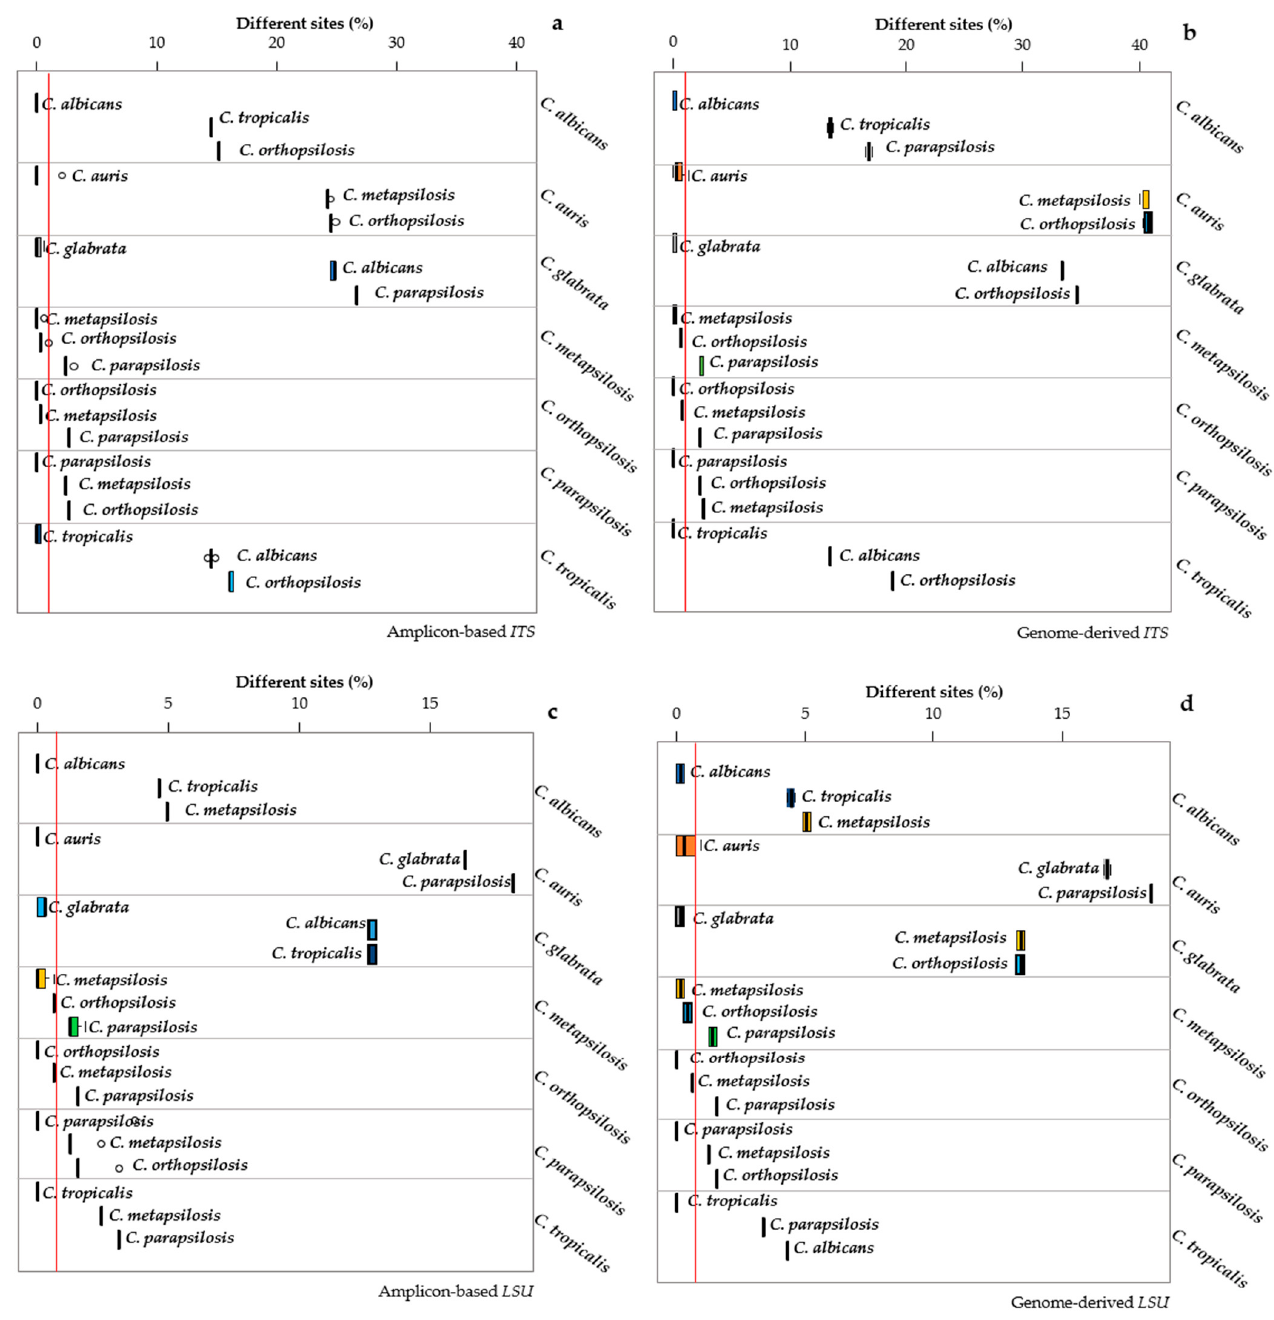
Figure 2. Distances among and within Candida species. The distances obtained with standard and genomic ITS are displayed in panels ( a , b ), respectively. The standard and genomic distances from the LSU markers are reported in panels ( c , d ). Each subpanel reports the distances of the strains belonging to the species under study (indicated on the right of the subpanel) with the sequences of the type strains of the three closest species (indicated close to the box). For instance, the topmost subpanel of ( a ), reports the intra and interspecific distances of C. albicans from the sequences of the C. albicans , C. tropicalis and C. orthopsilosis type strains. The width of each box represents the variability of the distances of the strains of each species from the type strains of the three closest species. The internal variability of each species is indicated by the topmost box of each subpanel. The distances among the means of the species are displayed as the distances between the vertical thick segments within the boxes.